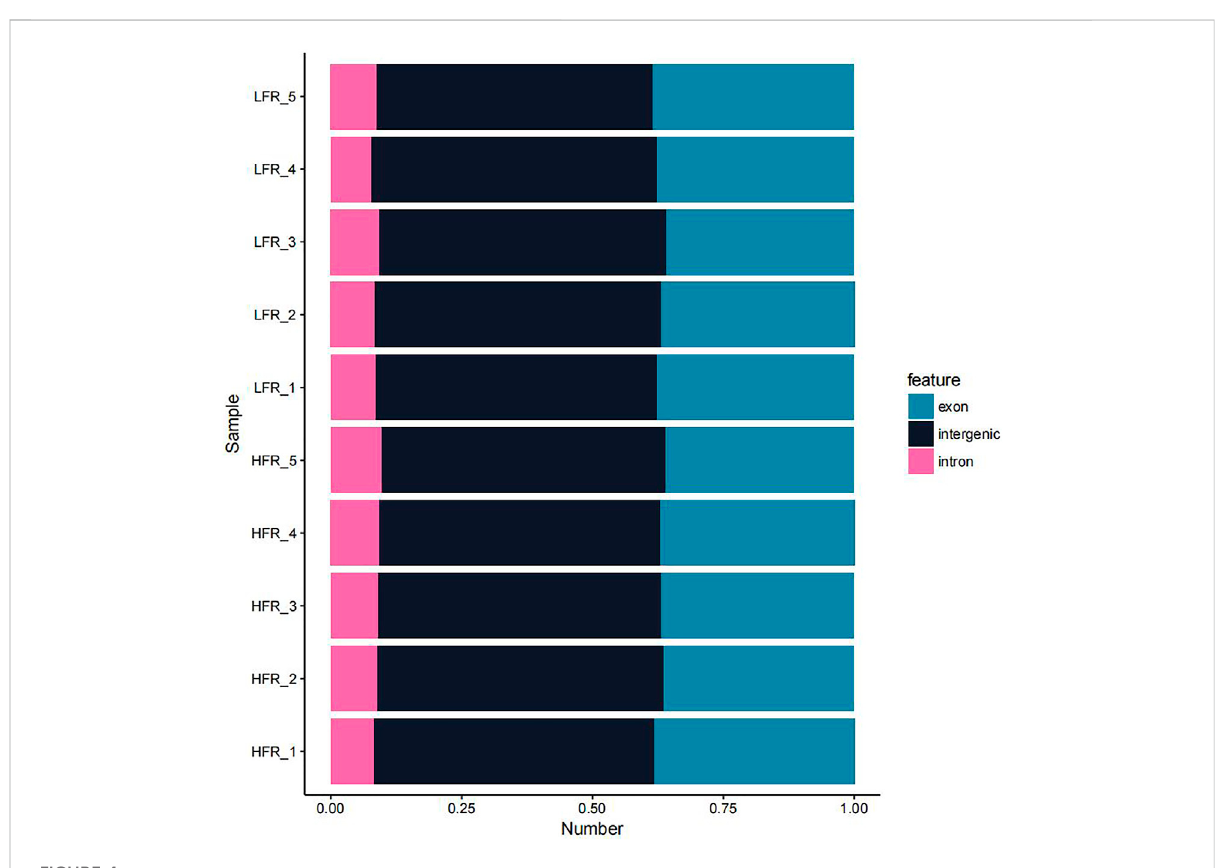
FIGURE 4 circRNA source statistics.